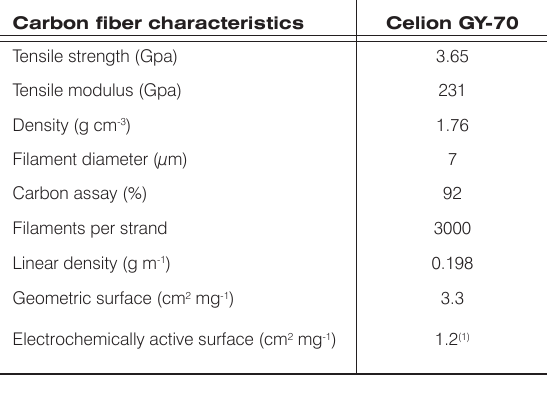
Table 1. Properties of PAN-based carbon